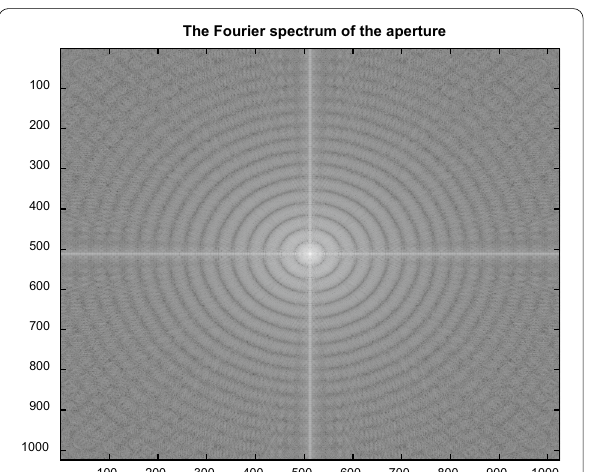
Fig. 3 a The PSF for the aperture shown in the Fig. 1a, in the range from 500 to 526 pixels. The cut‑off for the central lope 15 pixels = while the central peak at 14 pixels. FWHM 1 pixels. b The PSF for = the aperture shown in the Fig. 1b, in the range from 500 to 526 pixels. The cut‑off for the central lope 15 pixels while the central peak at = 14 pixels. FWHM 1 pixels. c The PSF for the aperture shown in the = Fig. 1c, in the range from 500 to 526 pixels. The cut‑off for the central lope 15 pixels while the central peak at 14 pixels. FWHM 1 pixels. = = The side lobes are strengthen compared with that shown in the figure ( b ). d The PSF for the whole square of dimensions 640 640 × pixels in the same range as in the figure ( c ). The cut‑off for the central lope 17 pixels while the central peak at 14 pixels. FWHM 3 = =